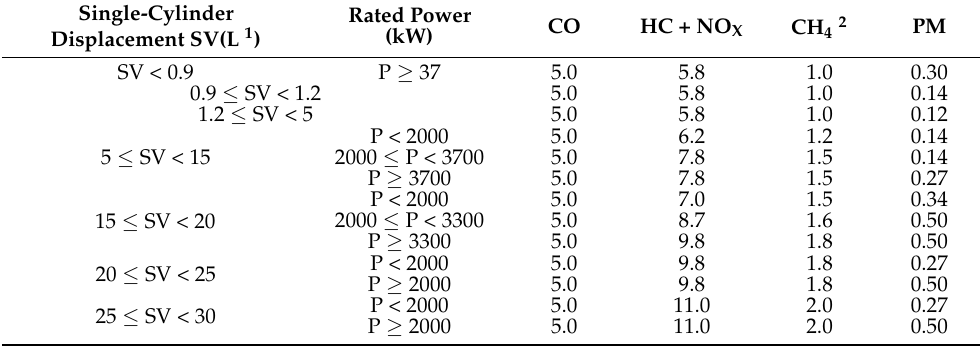
Table 3. CHINA II emission limit